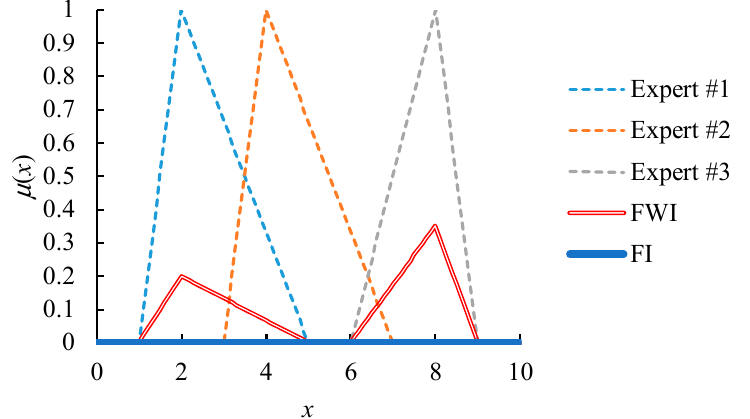
Figure 1. The fuzzy weighted intersection (FWI) result when decision makers lack an overall consensus.